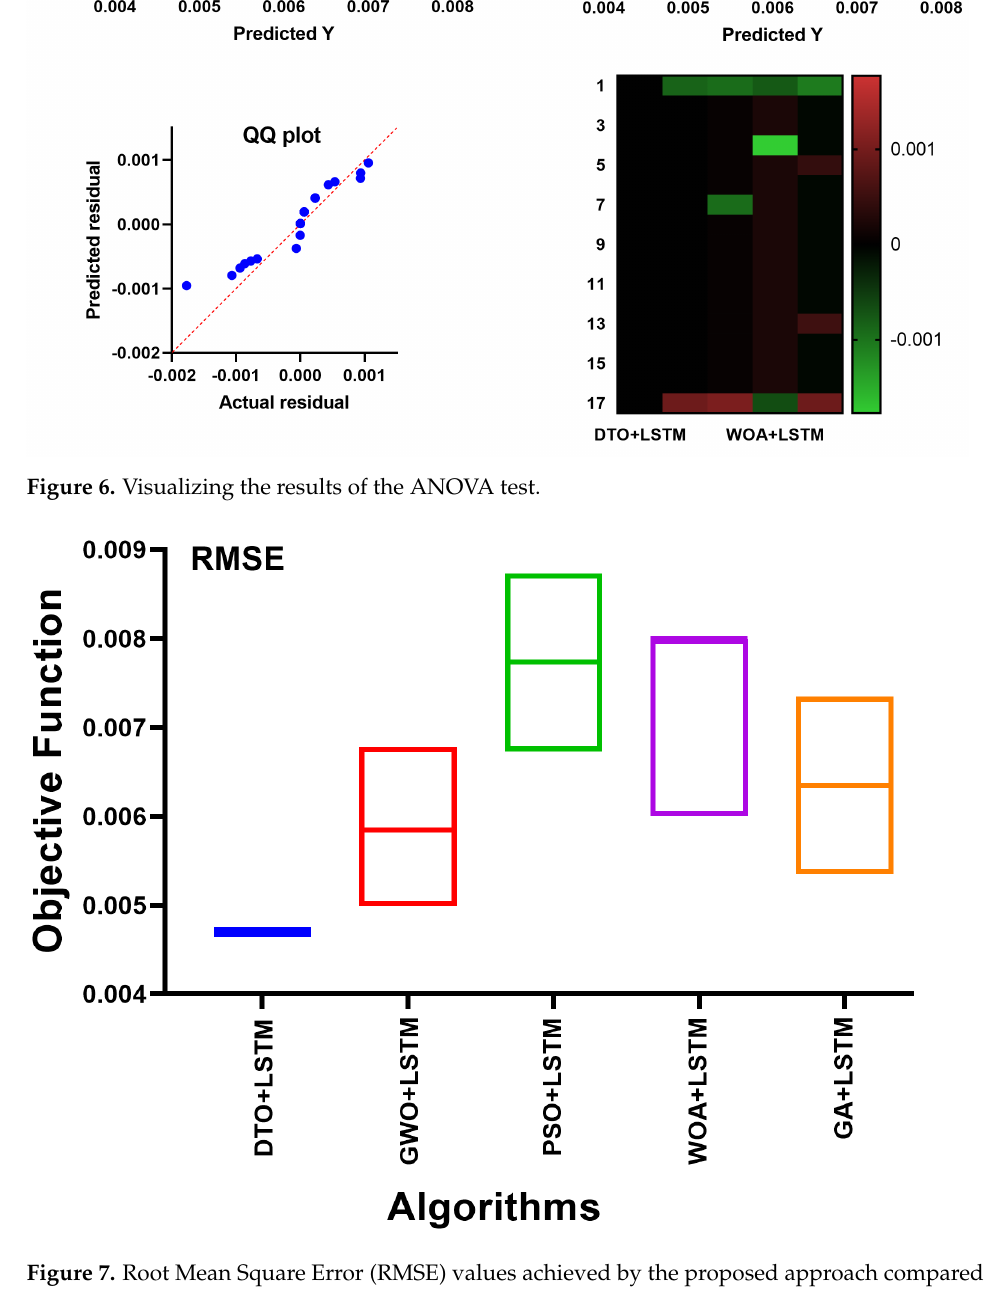
Figure 7. Root Mean Square Error (RMSE) values achieved by the proposed approach compared to the other